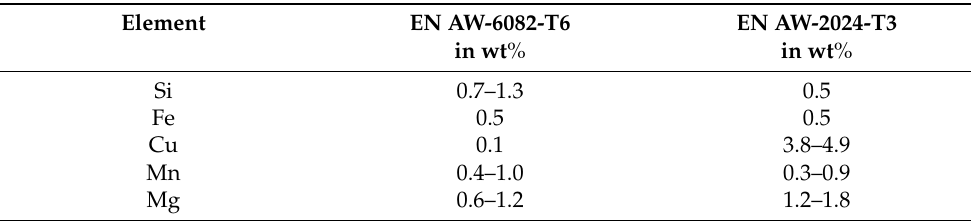
Table A1. Percentage of the alloy elements (wt%) for the different aluminum alloys according to